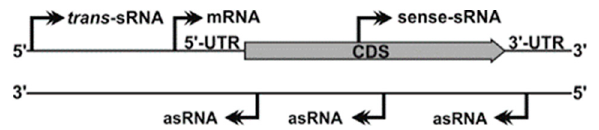
Figure 1. The prokaryotic non-coding transcriptome as revealed by dRNA-Seq. Identified Transcription Start Sites (TSSs; shown by arrows) can be assigned to mRNA and the different sRNA types ( trans -sRNAs, asRNAs and mRNA-derived sense-sRNAs). See text for further details.